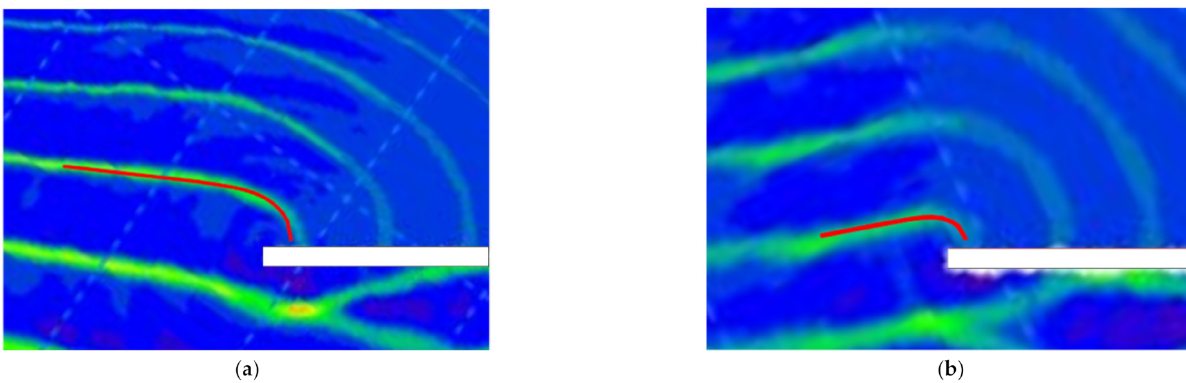
Figure 8. Hyperbolic tangent profile (red line) corresponds to relative wave front; both pictures have been obtained with the gentle slope configuration, ( a ) with wave direction − 35 ◦ and wave period of 10 s and ( b ) with wave direction 25 ◦ and wave period of 10